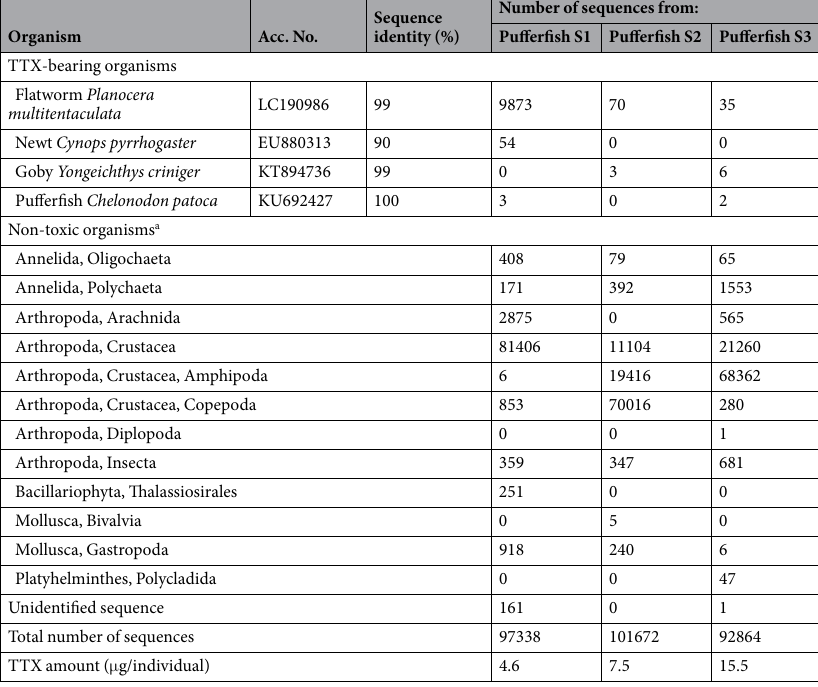
Table 2. DNA sequences from the intestinal contents of the pufferfish Takifugu niphobles juveniles collected at Katase in July 2016. The pufferfish juveniles were randomly selected from the specimens collected at Katase in July 2016, shown in Table 1. a The list of sequences from non-toxic organisms are shown in the supplementary data (Table